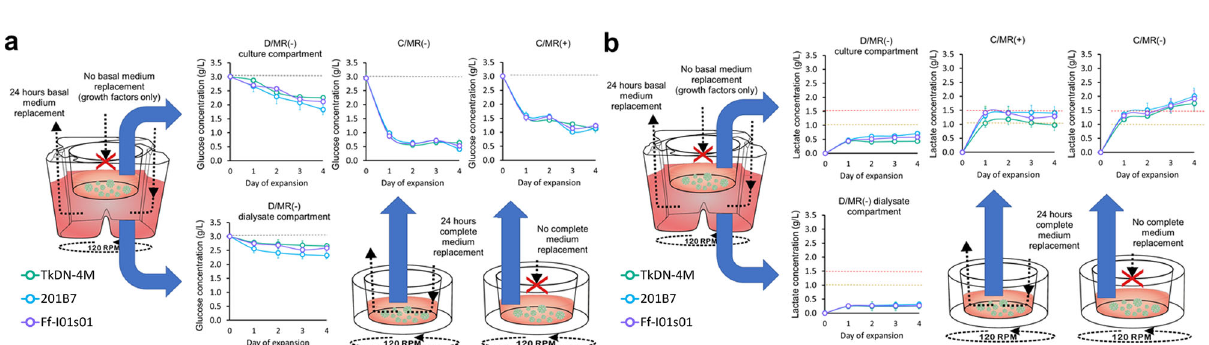
Fig. 3 The concentration of glucose and lactate in the culture medium partially re fl ects the culture environment condition in a different con fi guration. a The glucose concentration and b the lactate concentration in culture medium. Gray line showed the glucose concentration in the culture medium. The critical lactate concentration for PSCs culture described by Ouyang et al. 24 indicated in red line and critical lactate concentration for PSCs culture, which described by Horiguchi et al. 23 indicated by the yellow line. (D/MR( − ) and C/MR( + ): n = 3 biologically independent experiments during fi ve passages; C/MR( − ): n = 3 biologically independent experiments during one passage). Mean± standard deviation are indicated in each